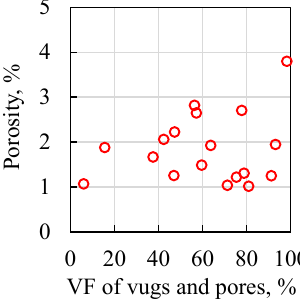
Figure 11. The cross plot of the sum of the volume fractions (VF) of vugs and pores against the He gas porosity.